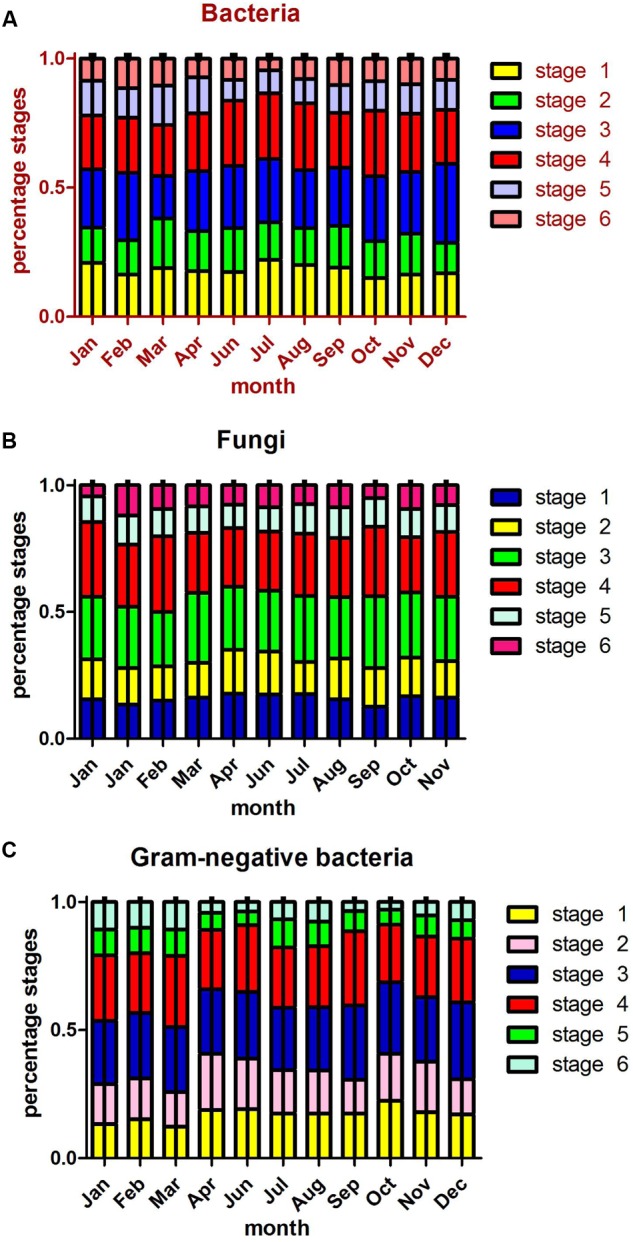
The Average monthly hierarchical distribution maps of bacteria (A), fungi (B), and Gram-negative bacteria (C).